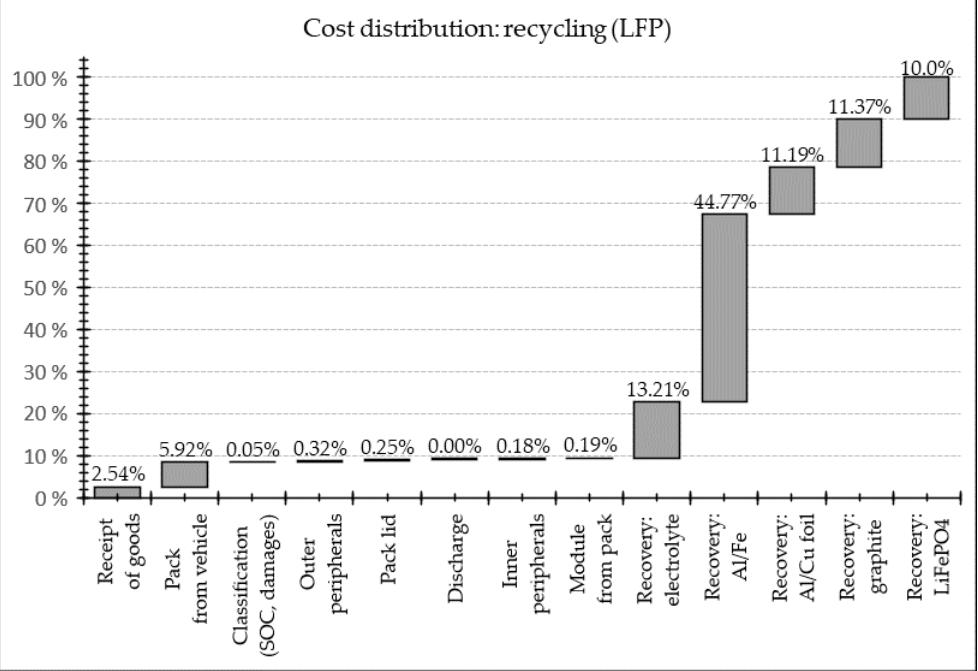
Figure 9. Cost distribution for the recycling (LFP) scenario under standard cost assumptions.